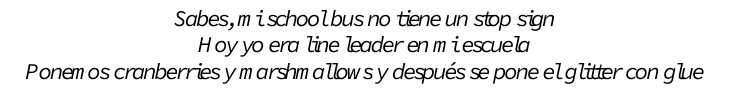
Table 14: Switching Spanish and English codes: several examples. (Snow, 1999: